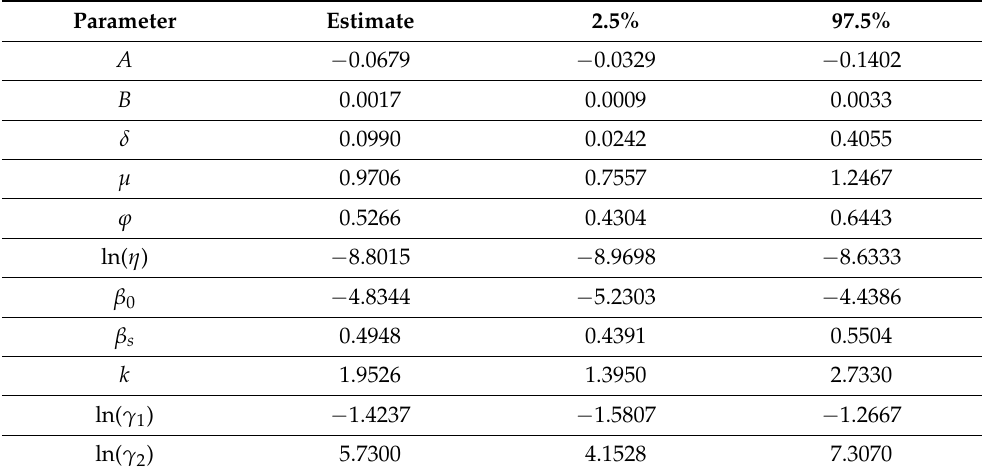
Table A1. Parameter values used in the simulation study.